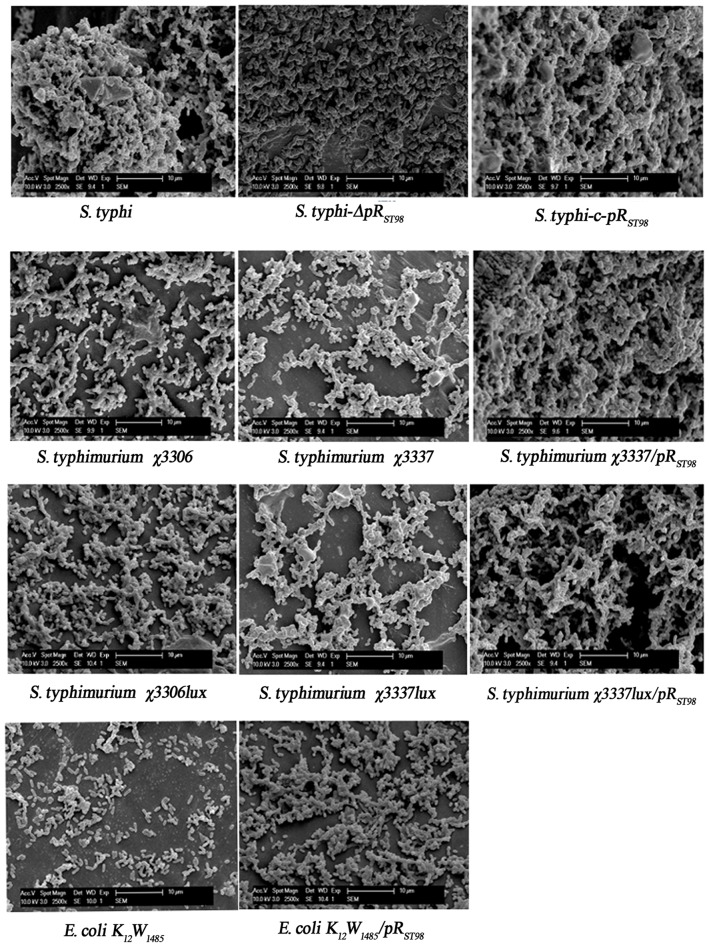
Observation of BF by SEM.Different bacteria were cultured in 24-well plates for 3 d, and the developed pellicles were harvested, placed on glass slides, and subjected to SEM.